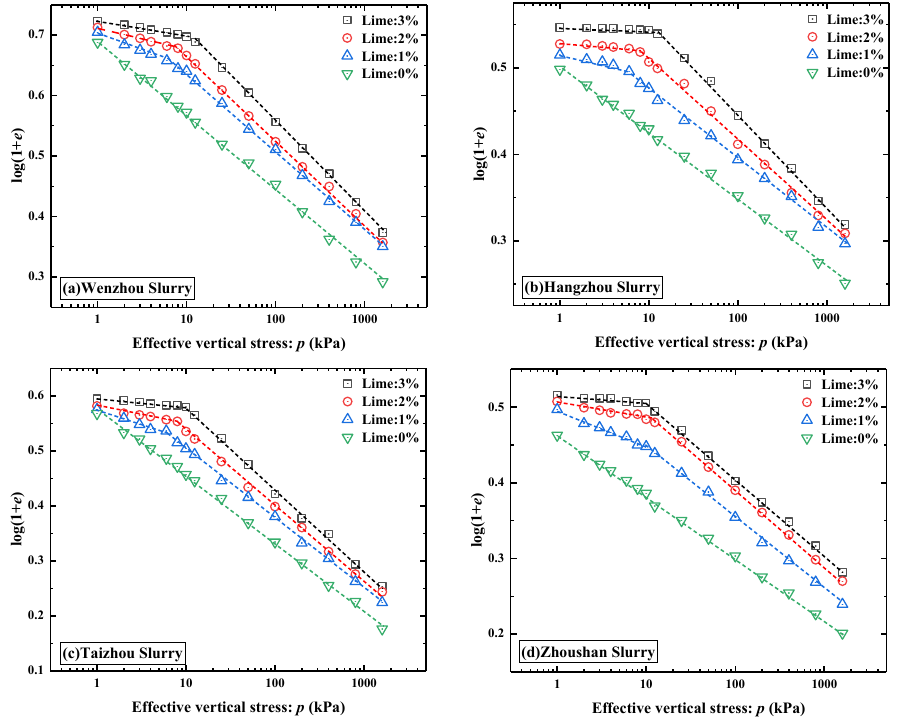
Figure 2. The log(1 + e )–log p curves of slurry for each group with different lime dosages. ( a ) Wenzhou soil sample, ( b ) Hangzhou soil sample, ( c ) Taizhou soil sample, ( d ) Zhoushan soil sample.